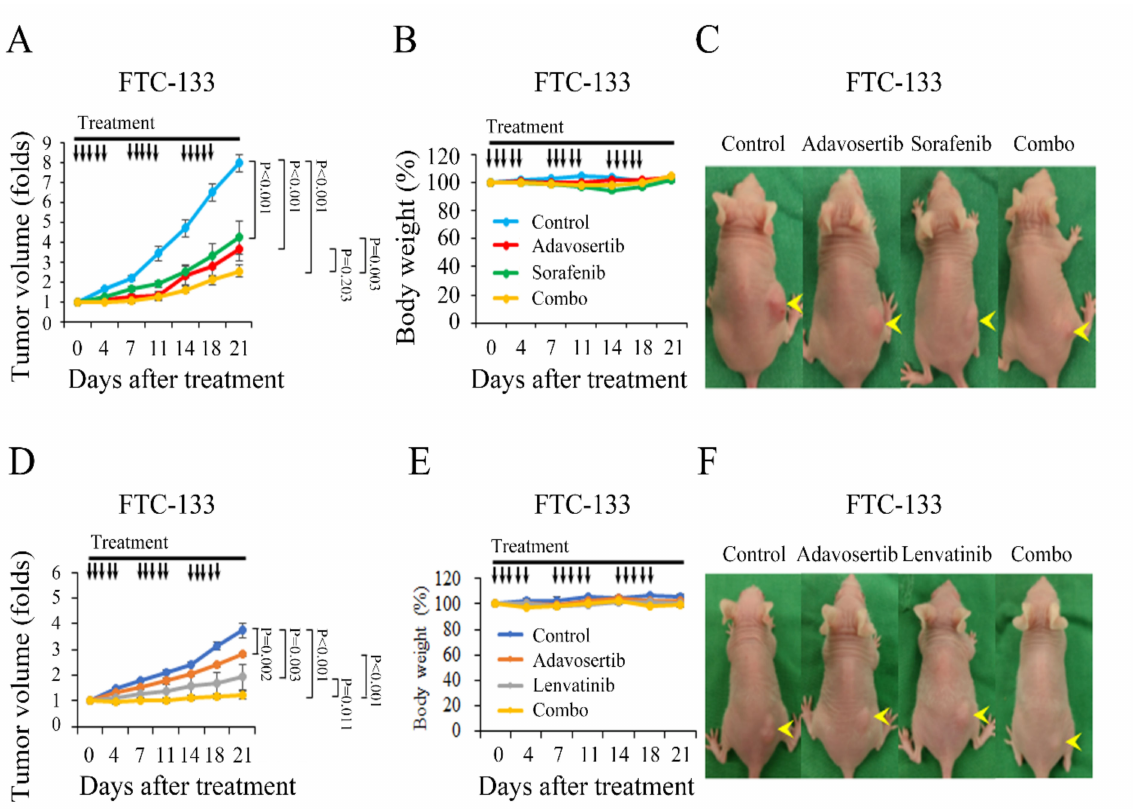
Figure 7. Adavosertib retards subcutaneous xenograft growth in a follicular thyroid cancer model. ( A ) Mice bearing FTC-133 flank tumors were treated with oral gavage of placebo, adavosertib (50 mg/kg), sorafenib (40 mg/kg), or combination therapy of adavosertib and sorafenib daily for three cycles of 5 days on and 2 days off. Compared with control therapy, adavosertib, sorafenib, and combination therapy significantly retarded FTC-133 tumor growth. Combination therapy did not significantly retard FTC-133 xenograft growth when compared with either adavosertib or sorafenib single-agent treatment. ( B ) Adavosertib, sorafenib, and combination therapy did not significantly reduce body weight compared with control treatment. ( C ) FTC-133 xenograft tumors (arrowhead) were photographed on day 21. ( D ) Nude mice with established FTC- 133 flank tumors were treated with oral gavage of placebo, adavosertib (50 mg/kg), lenvatinib (30 mg/kg), or combination therapy of adavosertib and lenvatinib daily for three cycles of 5 days on and 2 days off. Adavosertib, lenvatinib, and combination therapy significantly inhibited FTC-133 tumor growth when compared with control treatment. Combination therapy significantly inhibited FTC-133 xenograft growth when compared with adavosertib and lenvatinib single-agent treatment. ( E ) No substantial decreases in body weight were attributable to adavosertib, lenvatinib, or combination therapy compared with control treatment. ( F ) Mice bearing FTC-133 tumors (yellow arrow) were photographed on day 21. Arrow, placebo, adavosertib, sorafenib, lenvatinib, and combination